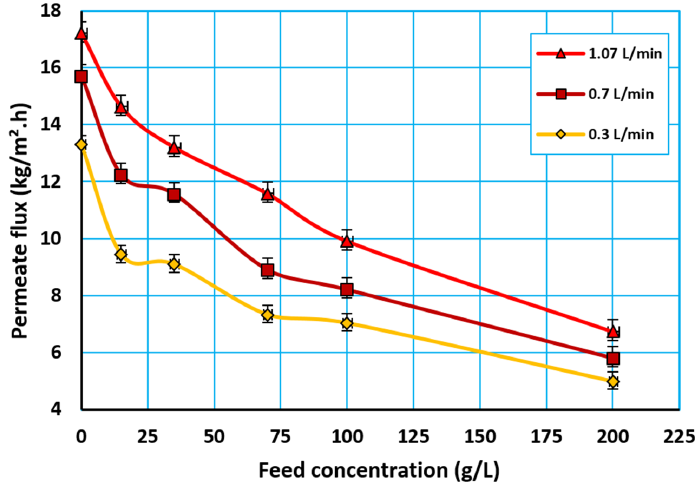
ff ect of the feed concentration on the permeation flux at 60 ◦ C feed Figure 6. Effect of the feed concentration on the permeation flux at 60 °C feed temperature. Figure 6. E